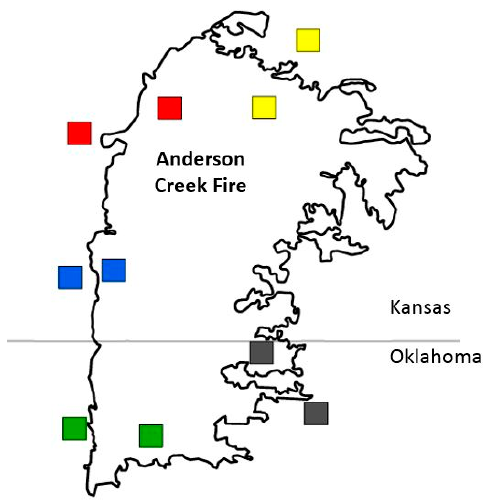
Figure A1. Illustration of paired burned (B) and unburned (U) plots for analysis of the 2016 Anderson Creek fire. Each color pair represents different soil-cover type-topographic combinations of characteristics.